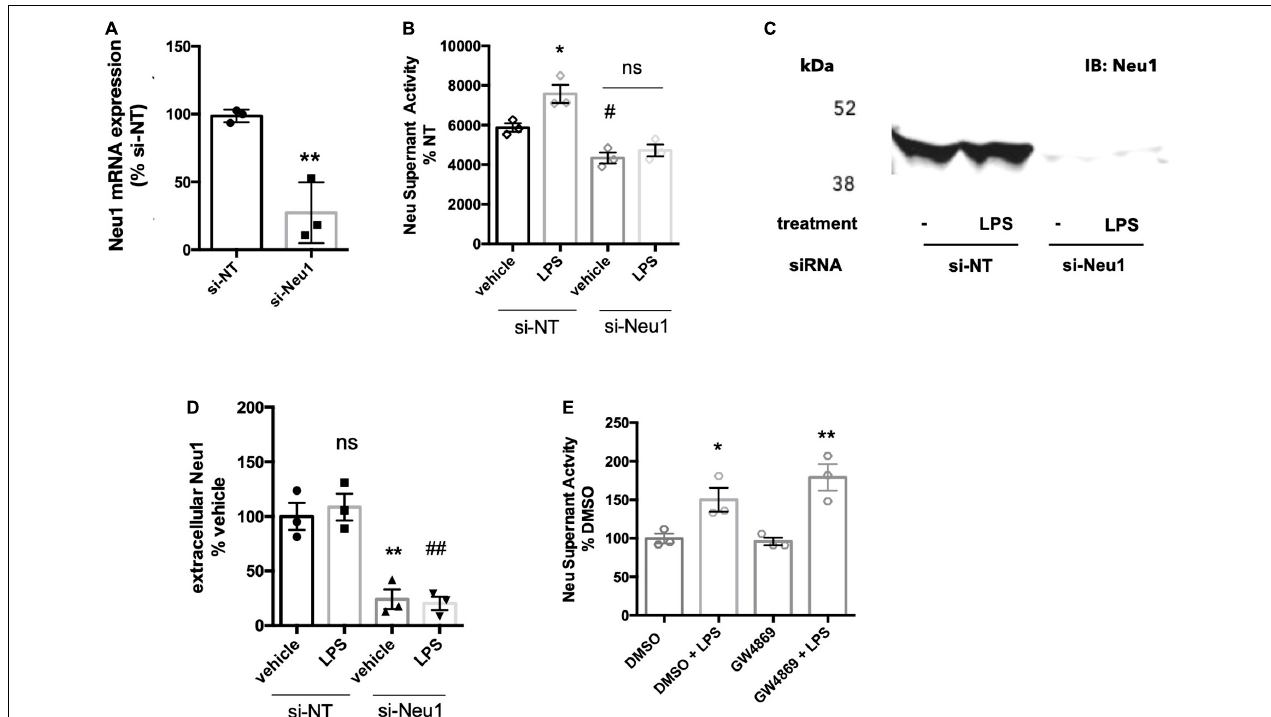
FIGURE 1 | BV-2 microglia release Neu1 into culture supernatants. (A) mRNA expression of Neu1 in non-targeting (si-NT) or Neu1-targeting (si-Neu1) siRNA-transfected BV-2 microglia. Knockdown was assessed 24 h after siRNA treatments. Data presented as mean Neu1 expression levels of three independent BV-2 culture preparations ( ± S.E.M) normalized to the si-NT control. Statistics: unpaired t -test, ** p < 0.01. (B) Supernatant neuraminidase activity assays (pH 7.2) of vehicle or LPS-treated (100 ng/ml, 18 h) BV-2 microglia. 48 h prior to stimulation, BV-2 were transfected with non-targeting or Neu1-targeting siRNA. Data presented as mean neuraminidase activity assays of three independent BV-2 culture preparations ( ± S.E.M) normalized to the si-NT + vehicle control. Statistics: one-way ANOVA with Tukey’s post hoc analysis, * p < 0.05 vs. si-NT + vehicle, # p < 0.05 versus si-NT + vehicle, ns: non-significant. (C) Western blot of supernatants from si-NT or si-Neu1 transfected BV-2, stimulated with vehicle or LPS (100 ng/ml). Supernatants were concentrated 20-fold with a 10 kDa cut-off filter. Blot representative of three independent experiments. (D) Quantification of Western blots of culture supernatants from untreated and LPS-treated BV-2. Data presented as mean Western signal of three independent BV-2 culture preparations ( ± S.E.M) normalized to untreated control. Statistics: one-way ANOVA with Tukey’s post hoc analysis, ** p < 0.01 vs. si-NT + vehicle, ## p < 0.01 vs. si-NT + vehicle, ns: non-significant. (E) Supernatant neuraminidase activity assays (pH 7.2) of vehicle or LPS-treated (100 ng/ml, 18 h) BV-2 microglia. Cells were pretreated with neutral sphingomyelinase inhibitor GW4869 at 20 µ M or DMSO control for 1 h before addition of LPS. Data presented as mean neuraminidase activity assays of three independent BV-2 culture preparations ( ± S.E.M) normalized to DMSO